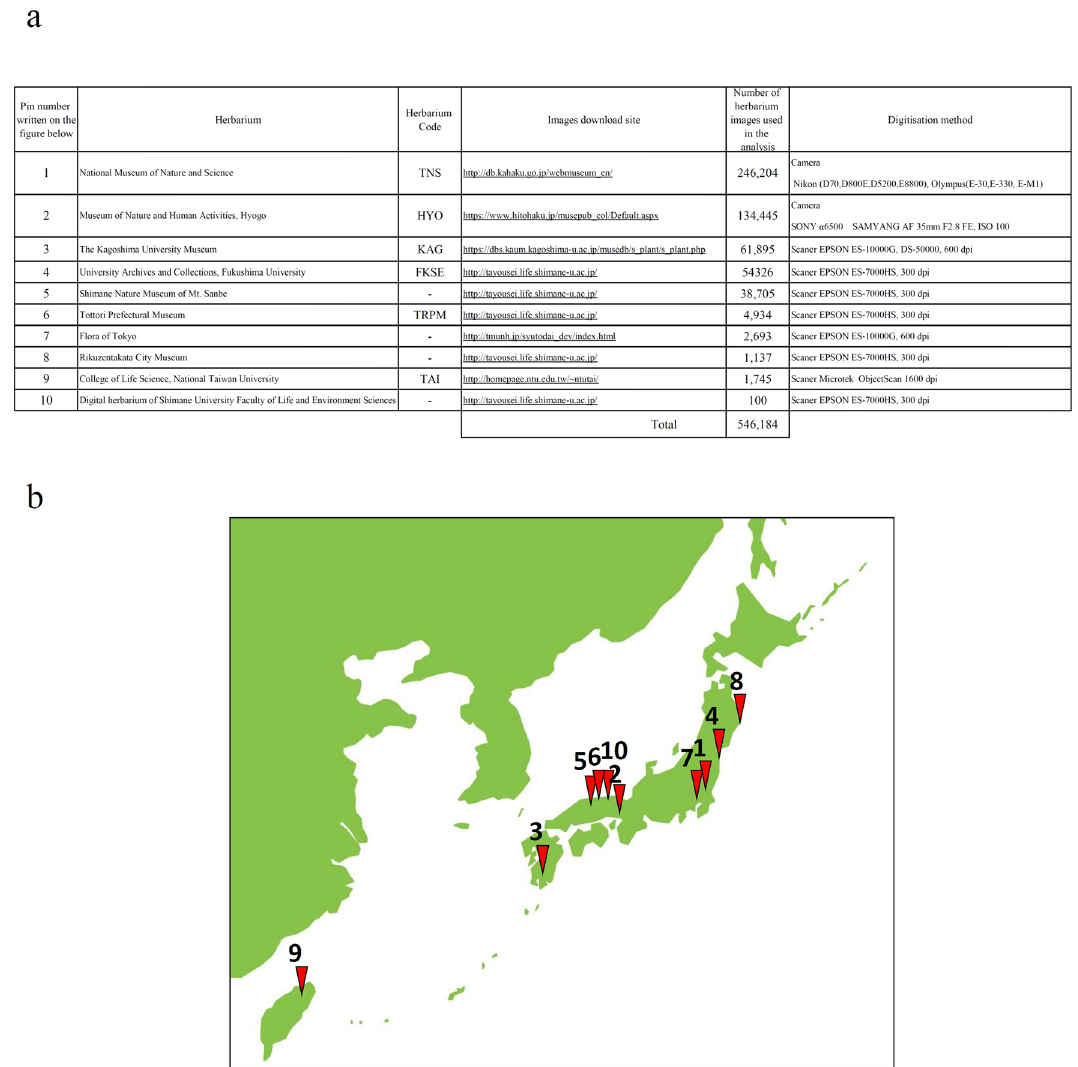
Figure 2. ( a ) List of herbarium-stored specimens used in this study. ( b ) Locations of specimen